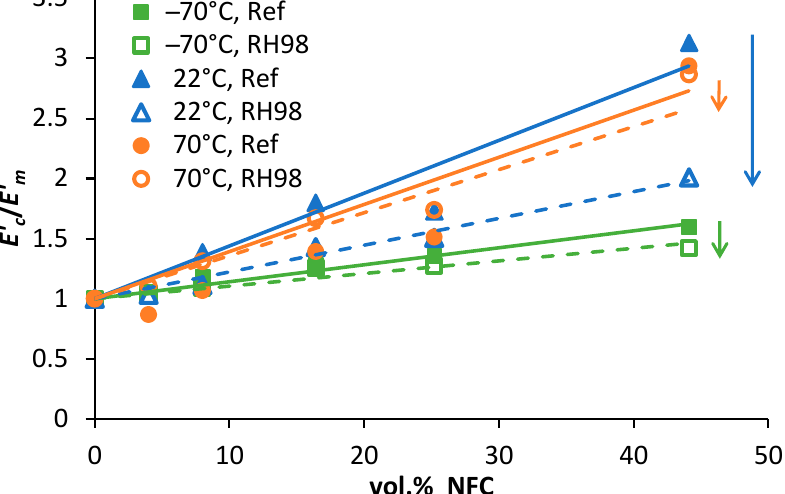
Figure 11. Relative storage moduli as a function of volume content of NFC of the reference and RH98 samples determined at − 70, 22, and 70 ◦ C. Solid and dotted lines are approximations.